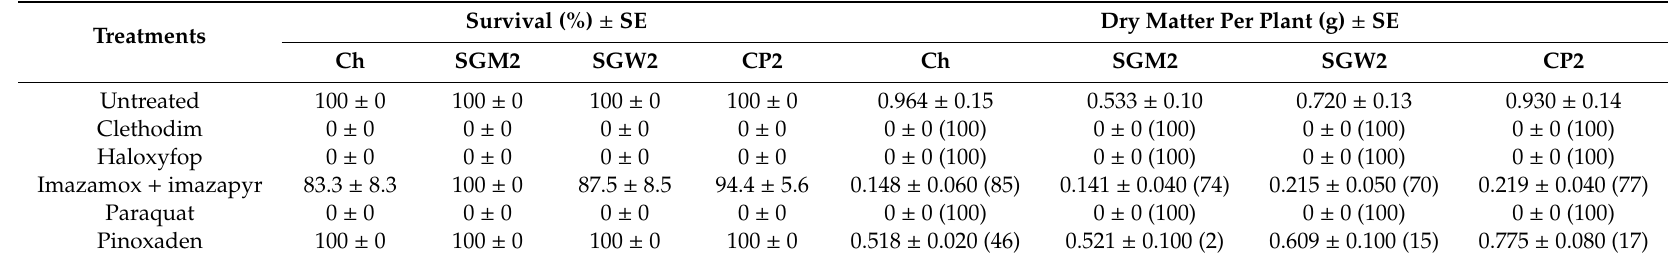
Table 6. E ff ect of di ff erent herbicide treatments on survival percentage and dry matter production of glyphosate-susceptible (Ch and SGM2) and glyphosate-resistant (SGW2 and CP2) biotypes of Chloris virgata after 28 days.